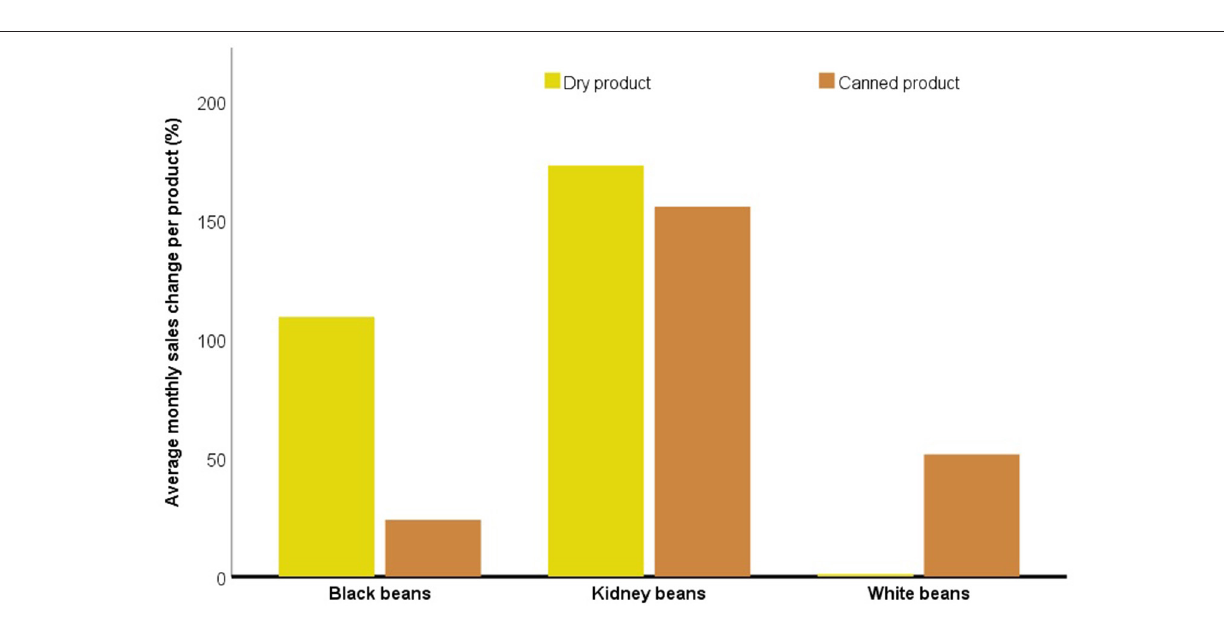
FIGURE 6 | Percent changes in average monthly customer purchases (in US$) of selected pairs of dry and canned legumes, comparing March and April 2019 and March and April 2020 ( p = 0.7) in nominal US$ values. 3.2% Consumer Food Price Index increase between April 2019 and April 2020 (US Bureau of Labor Statistics,